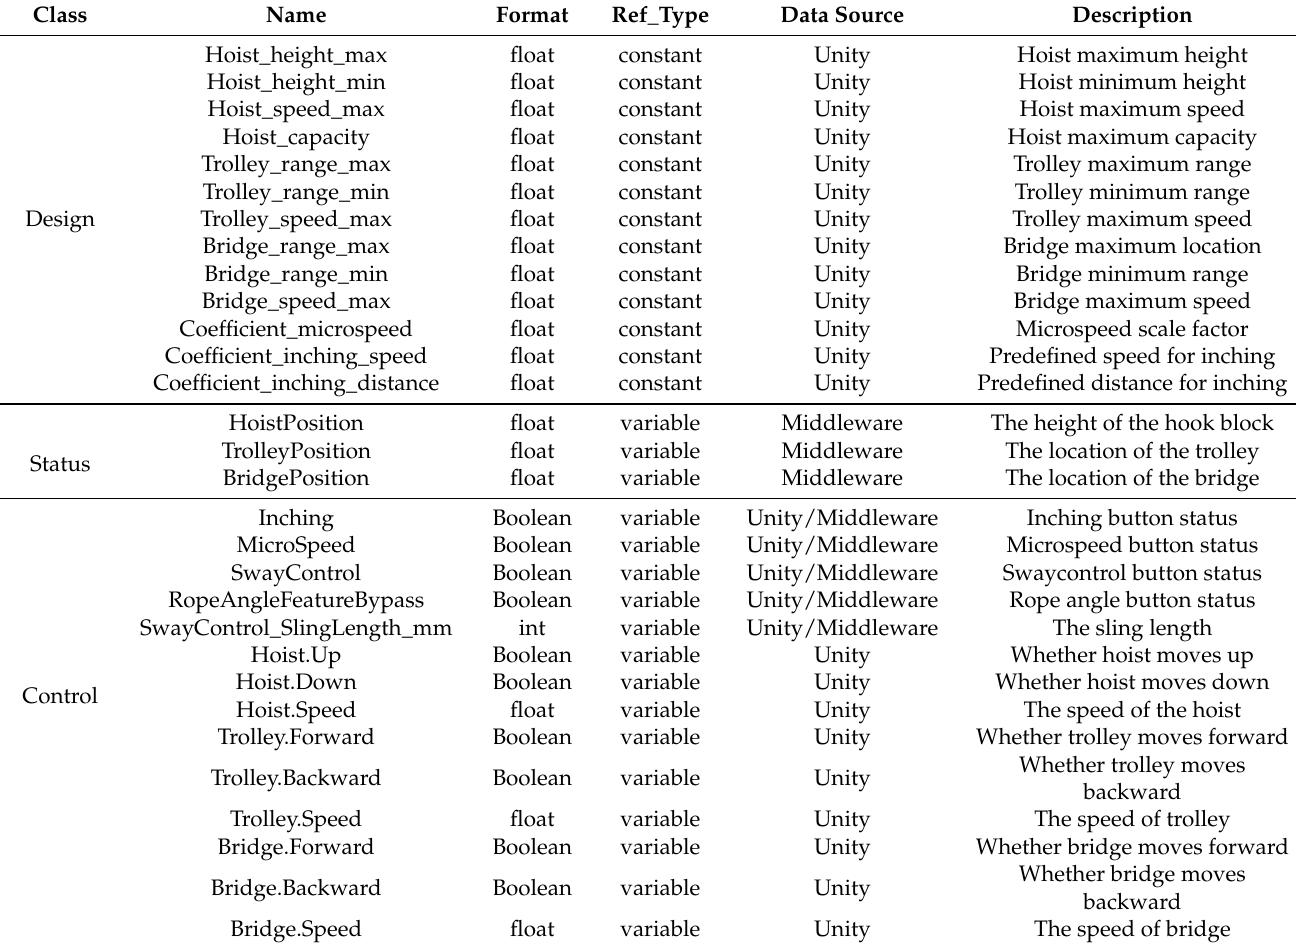
Table 3. Definition of data in the XR environment: The research defined the data class, name, basic format, reference type, source, and description to keep consistency with the internal and external interface. The Format defined the data basic type, such as int, float, char, etc. The reference type was categorized as constant and variable. The data source represented the source of the data. The Description depicted the definition of the